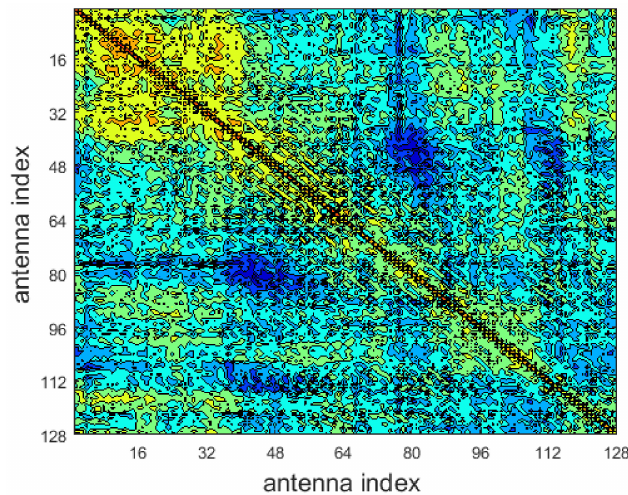
Figure 9. Channel correlation matrix